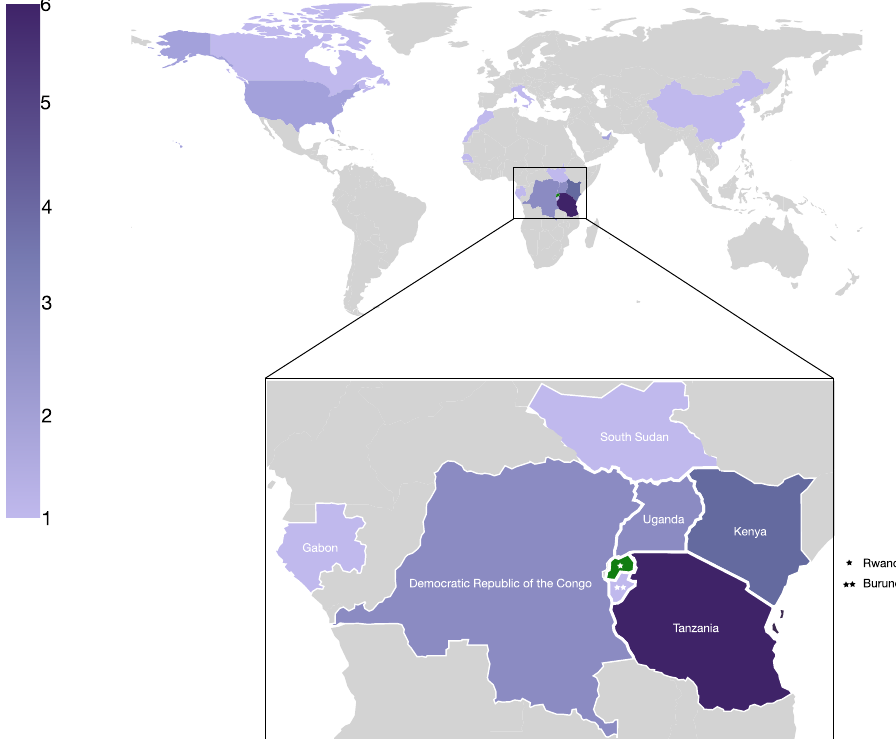
Fig. 2 Map showing the number of sequences with recorded travel history per country ( n = 28). While there is travel into Rwanda recorded from across the world, most cases are from neighboring countries, notably Tanzania (6), Kenya (3), Demographic Republic of Congo (3), Uganda (3), South Sudan (1), Gabon (1), and Burundi